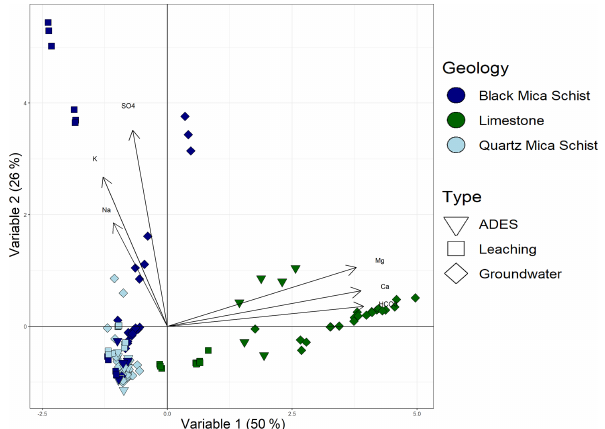
Figure 9. Principal component analysis.